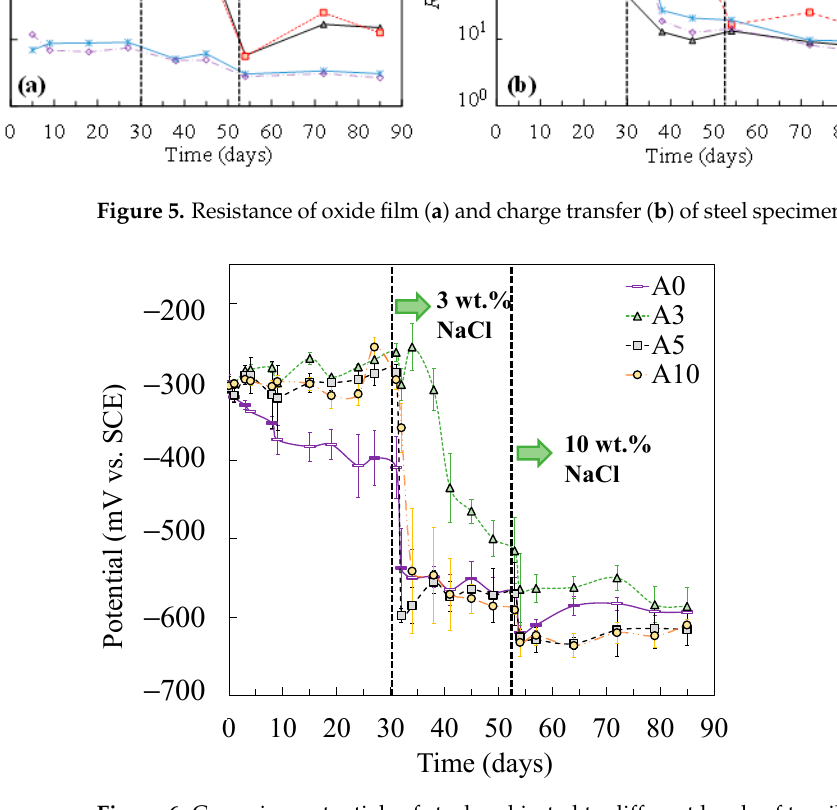
Figure 5. Resistance of oxide film ( a ) and charge transfer ( b ) of steel specimens at various stress levels.